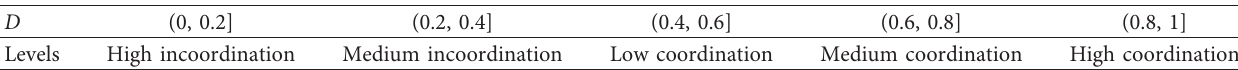
Table 2: Classification of